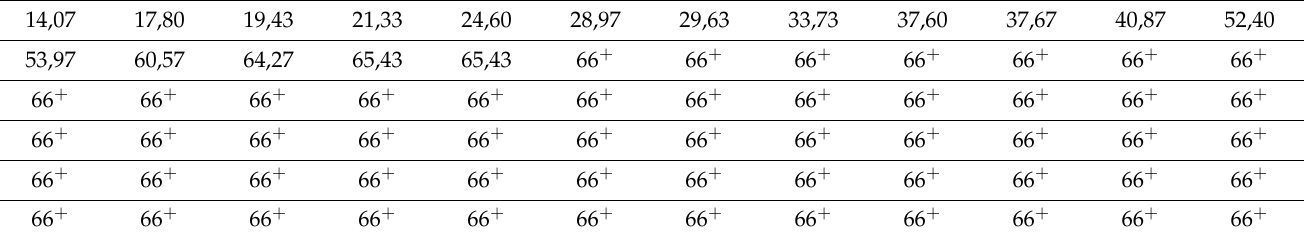
Table 4. First failure times (in months) of 72 desktops. Out of the 72 desktop computers, 17 desktops were reported to have failed at the time of the study. The failure times of the remaining 55 desktops were denoted by 66 + (this indicates that these computers had not failed by the time when the study was carried